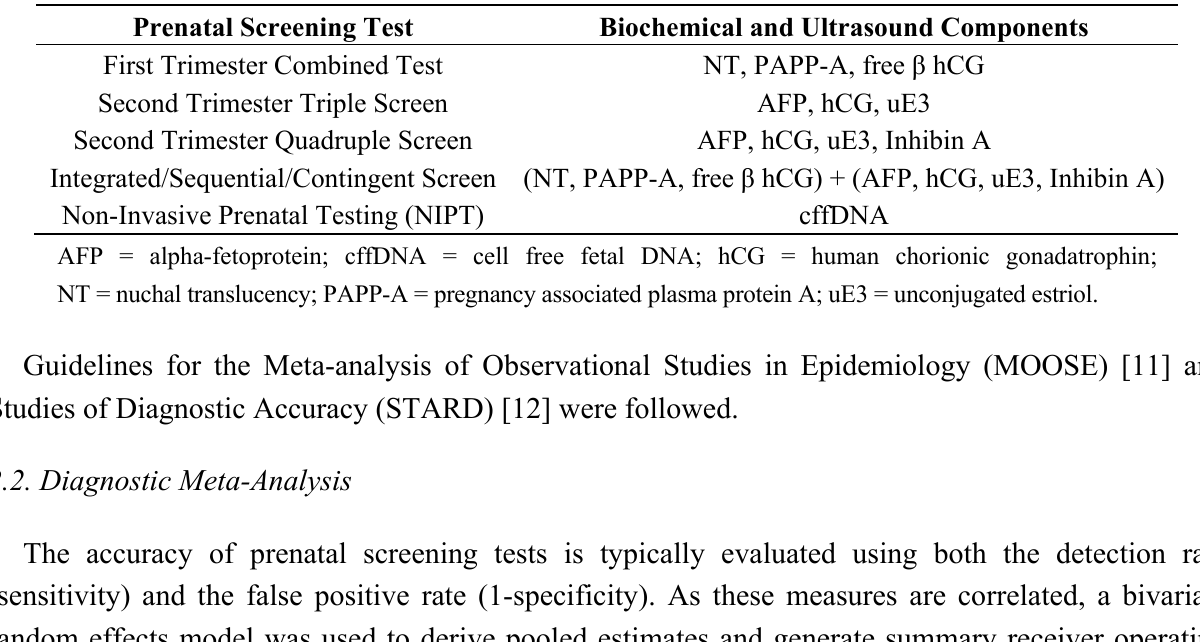
Table 1. Prenatal screening tests eligible for inclusion in systematic